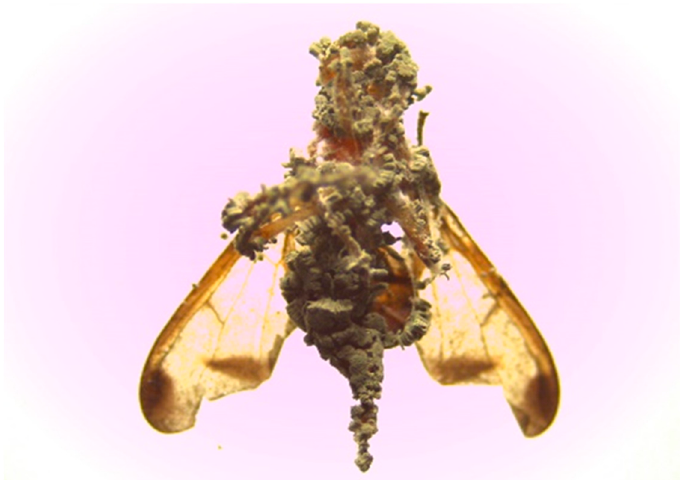
Figure 1. A mycosed adult melon fly ( Zaugodacus cucurbitae) due to Metarhizium anisopliae .